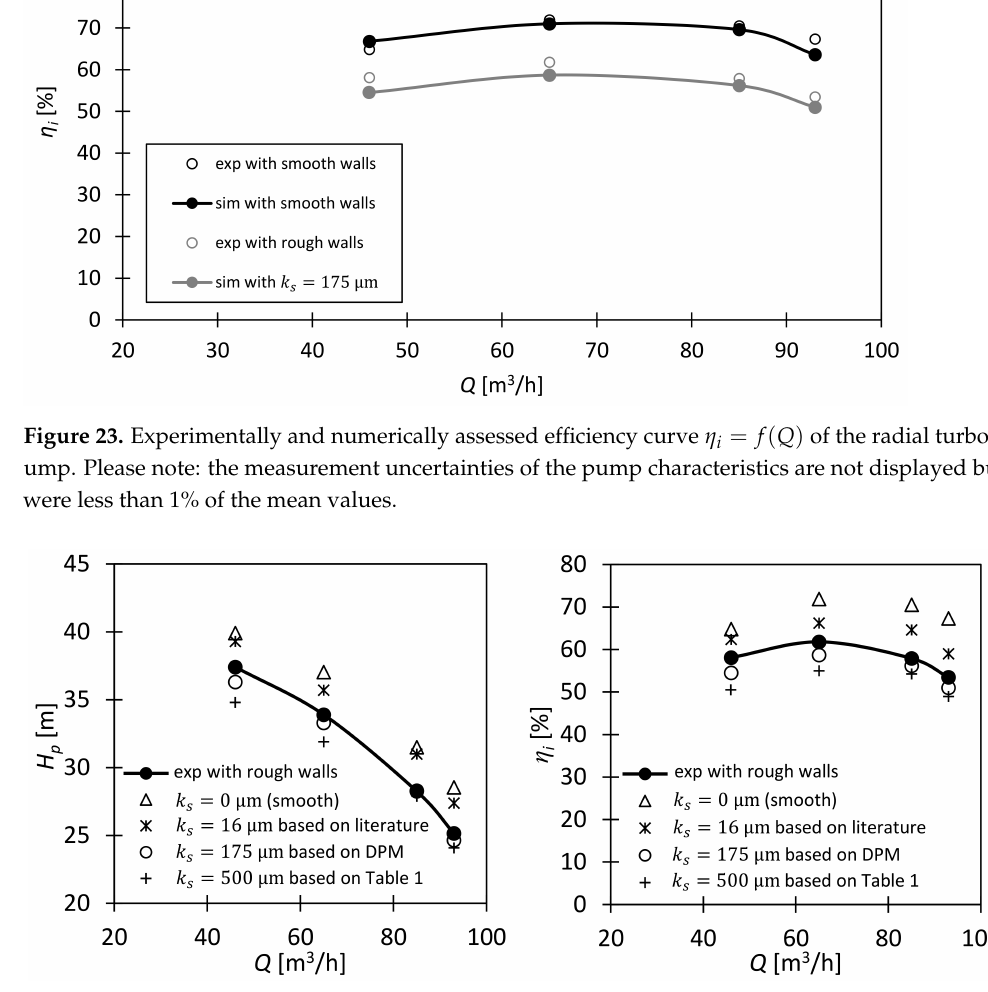
Figure 24. Numerically assessed pump characteristics of the radial turbopump. The k s -values for cast iron were estimated by three different methods: firstly, by an empirical correlation from the literature [21]. Secondly, by the DPM procedure. Thirdly, a representative value from Table 1 was